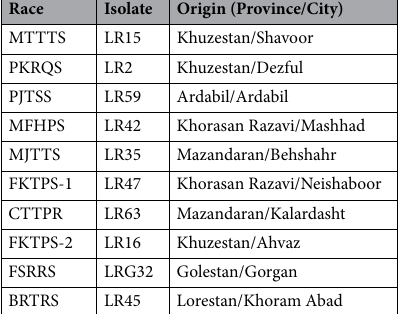
Table 4. Physiological race and collection site of 10 Pucnina. triticina isolates used for phenotypic assessment at the seedling stage on 185 wheat